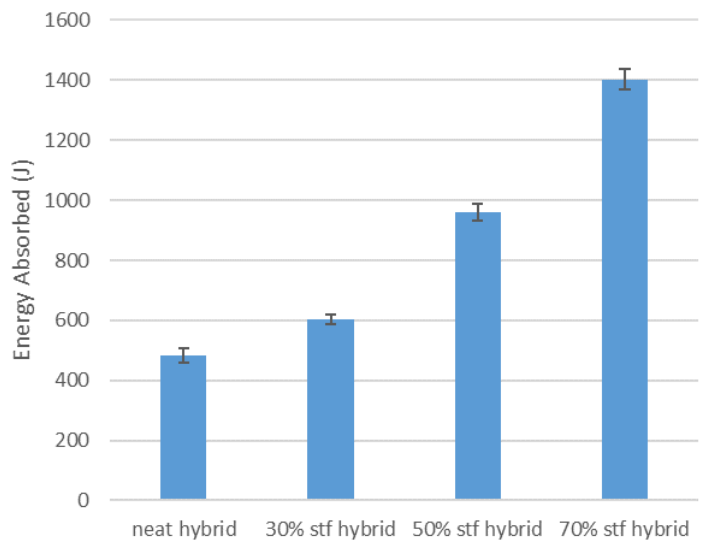
Figure 10. Comparison of ballistic impact energy absorption for hybrid samples.